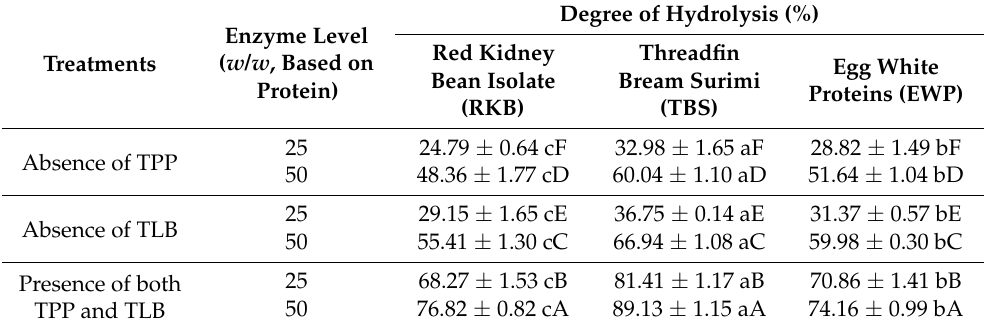
Table 1. Degree of hydrolysis of red kidney bean (RKB), threadfin bream surimi (TBS) and egg white protein (EWP) in various simulated in vitro gastrointestinal (GI) model systems without and with fish pepsin and/or trypsin at different